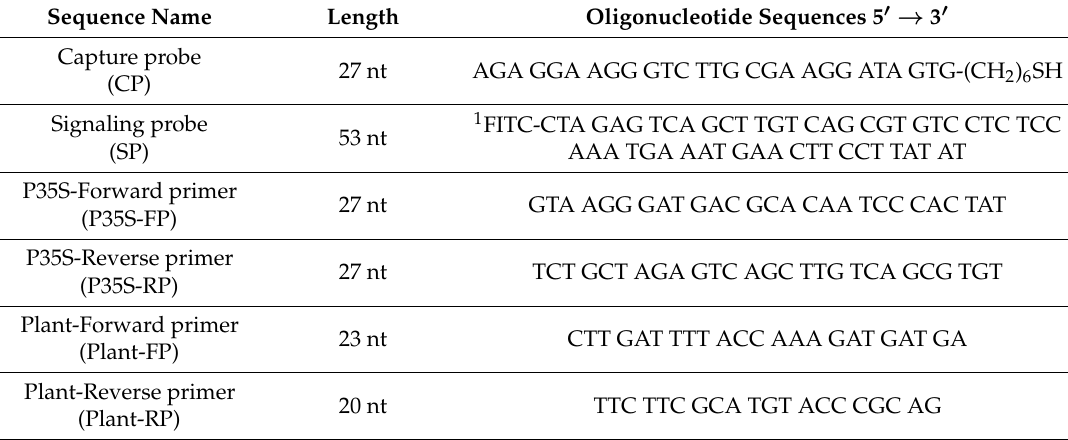
Table 1. Probes and primers sequences used in this